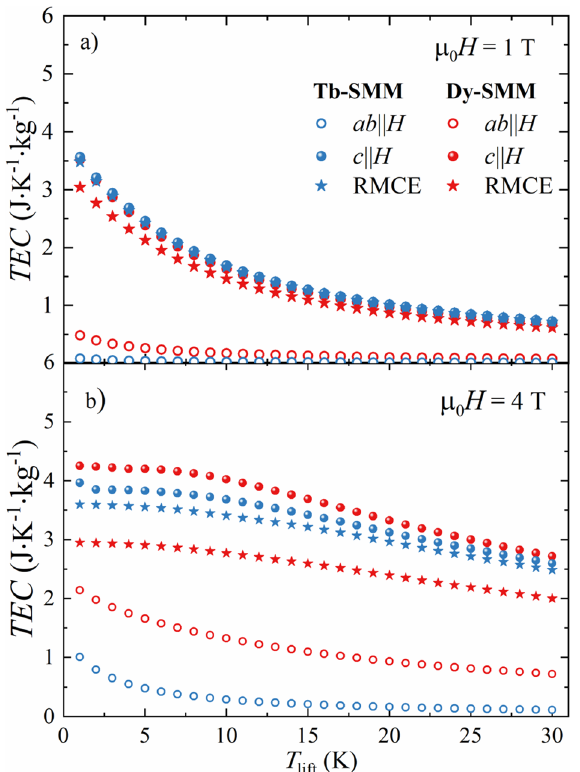
Figure 7. The temperature averaged entropy change (TEC) in the function of temperature interval Δ T lift for conventional MCE and RMCE for Tb-SMM and Dy-SMM calculated for the applied magnetic field of µ 0 H = 1 T ( a ) and µ 0 H = 4 T ( b ).